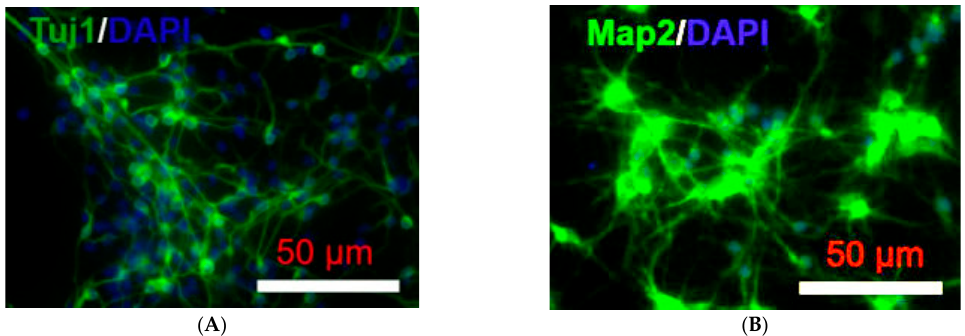
Figure 6. Immunofluorescence images of primary rat cortical neurons. ( A ) Representative double merged (FITC-labelled Tuj1 immunofluorescence (green) and DAPI-stained nuclei) of primary rat cortical neuron culture. The healthy neurons showed various long axons; ( B ) Representative double merged (FITC-labelled MAP2 immunofluorescence (green) and DAPI-stained nuclei) of primary rat cortical neuron culture. The healthy neurons showed numerous dendrites.